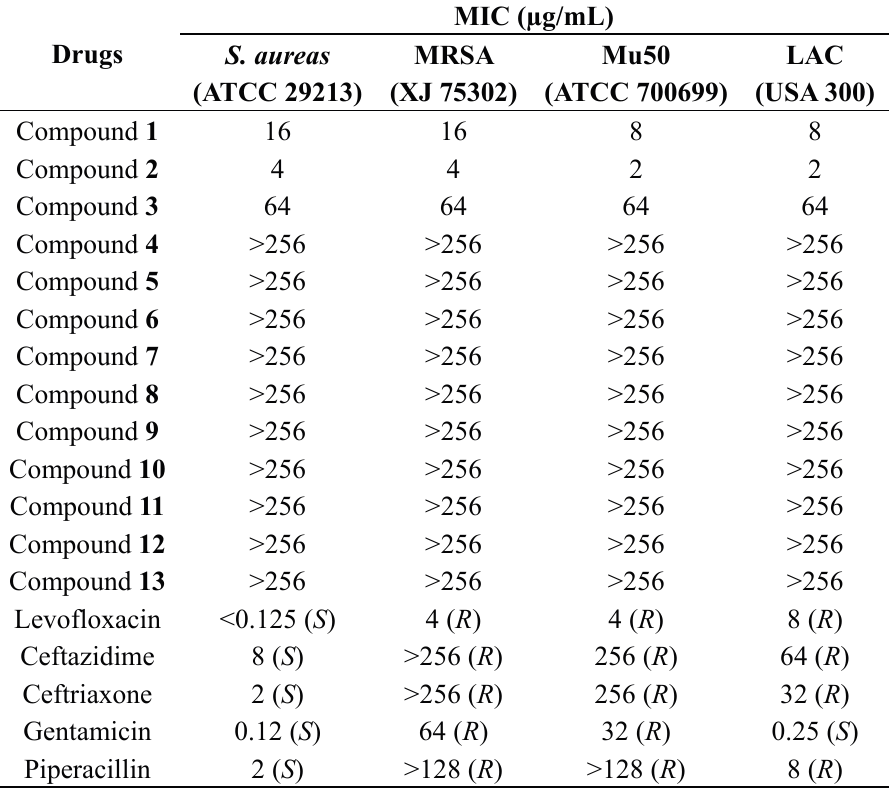
Table 2. Minimum inhibitory concentration (MIC) of compounds 1 – 13 and antibiotics in Mueller–Hinton Broth